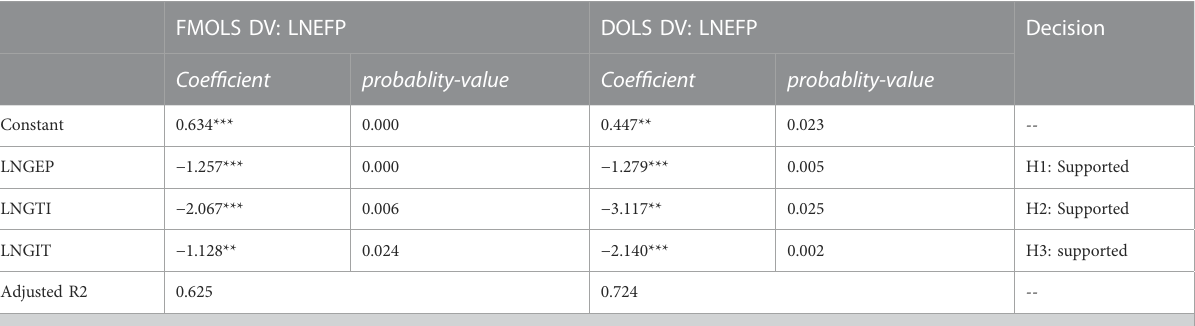
TABLE 6 Hypotheses testing